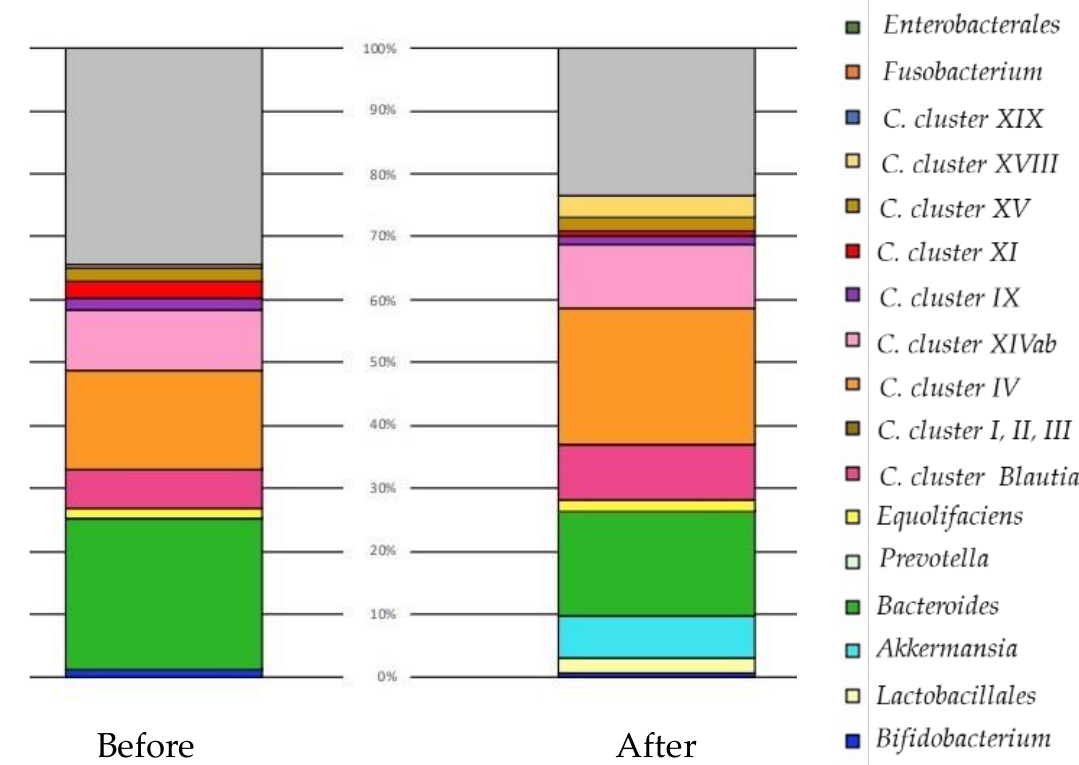
Figure 2. The change in the balance of intestinal microbiota by original profiling of 16SrRNA sequencing before and after the oral administration of probiotic capsules over three months. Forty-seven years old, female, breast cancer (left C region), T2N3aM0, stage IIIc, ER100% PgR40% HR2(3+) Ki67:50%. She took encapsulated Lactobacillus supplements for approximately three months. No adverse events were observed while taking encapsulated Lactobacillus supplements. After FMT, the diversity of intestinal bacteria increased. Akkermansia proliferated and immune cells may have been fortified. Lactobacillus increased, and may have progressed tissue repair and reconstructed tissue after destroying breast cancer. The size of her breast cancer remained unchanged, so she agreed to receive standard treatment. One year after the operation, she is in good general condition and is receiving hormone therapy. Clostridia (C) .